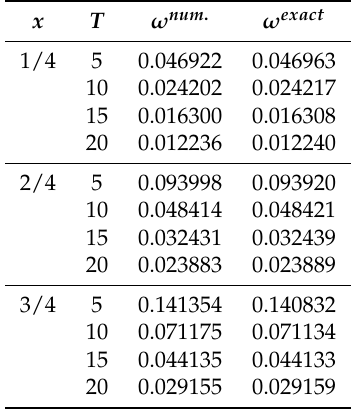
Table 3. Analytical results and numerical results by present method with τ = 0.01, ∆ x = 0.0125 and ν d = 0.01 for problem 5.1 at different value of T